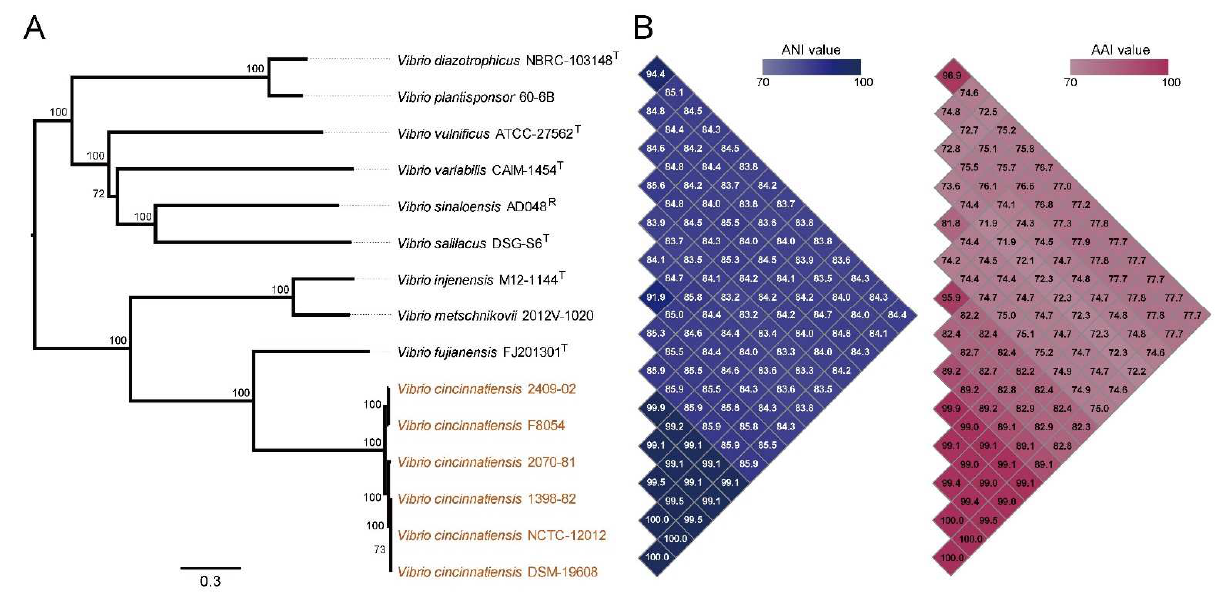
Figure 7. Phylogenetic, whole-genome nucleotide, and amino acid identity analysis. ( A ) Phyloge- netic tree based on SNPs across 1673 single-copy core gene families shared by 6 V. cincinnatiensis genomes and nine reference genome of other Vibrio species was constructed by the ML method with 100 replicates; ( B ) the values next to the tree indicate average nucleotide identity (ANI) and average amino acid identity (AAI) values. The heatmap presents ANI (blue matrix) and AAI (red matrix)